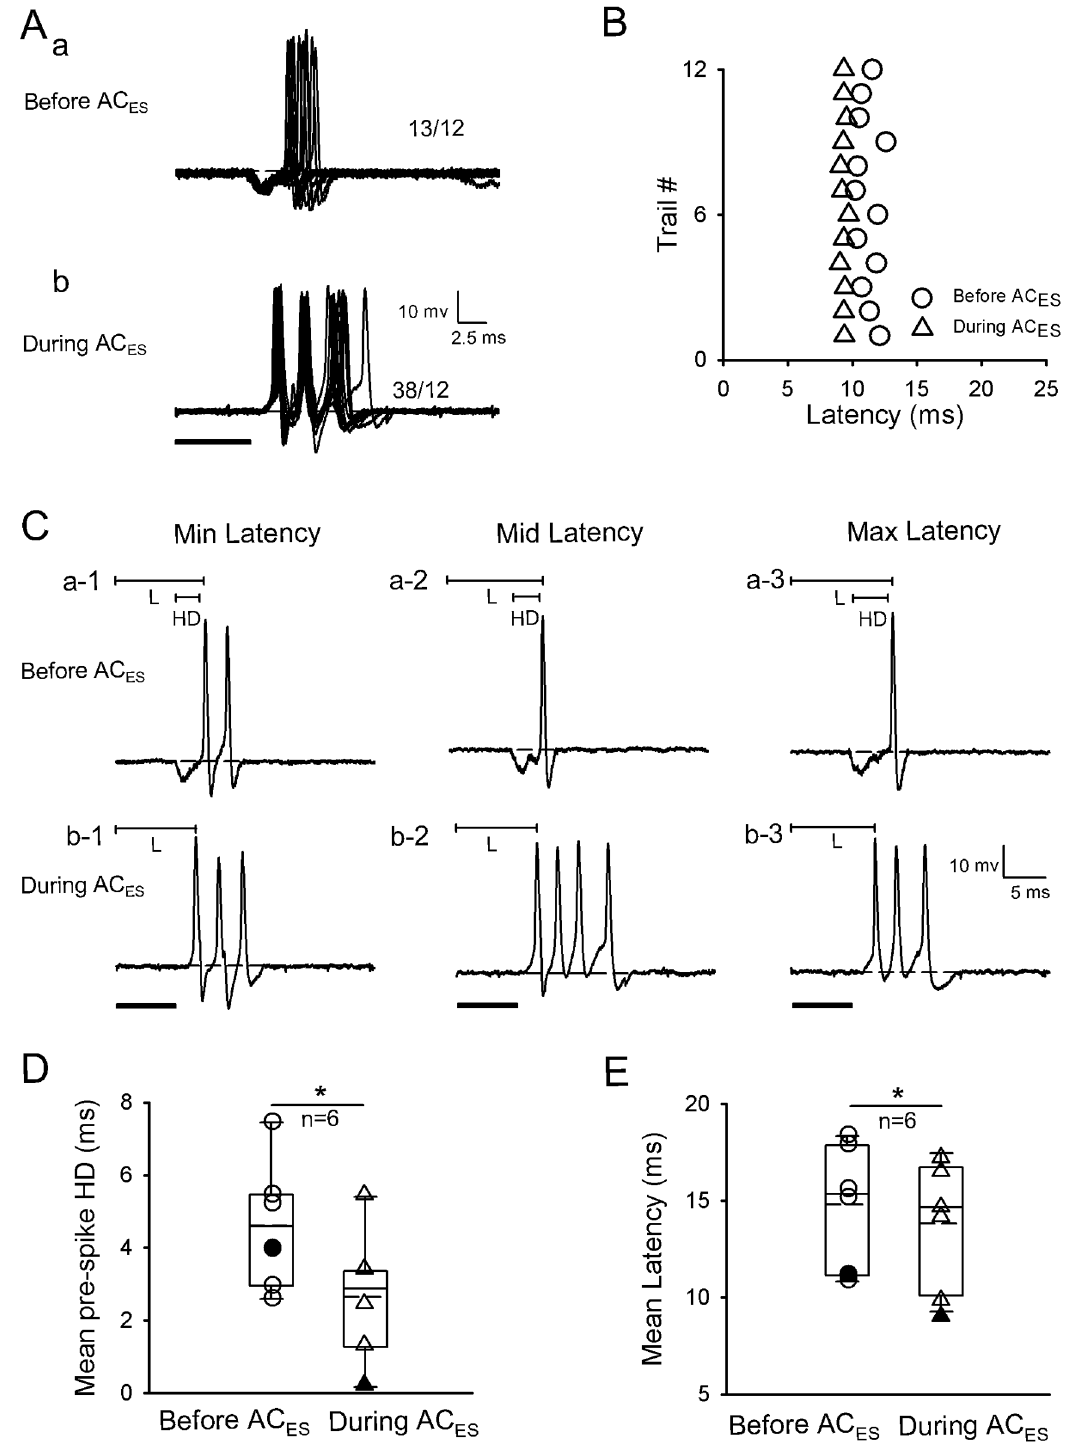
Fig 3. Representative facilitated IC neuron by AC ES showing its latency decreasing induced by pre-spike HD shortening. Originalresponsetraces obtained by 12 repetitive pure tone stimulationconditionsbefore (Aa) and during (Ab) AC ES . (B) Distributionof latency values calculatedaccordingto Aa and Ab before (unfilledcircle) and during (unfilled